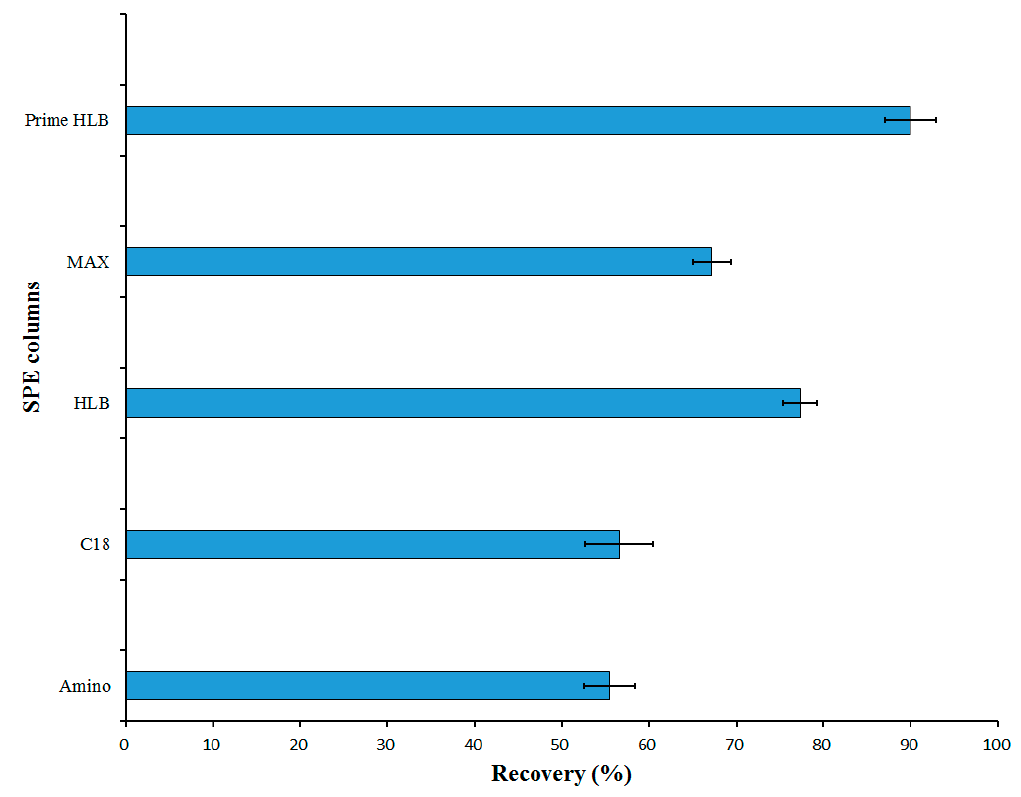
Figure 3. Recovery of different solid phase extraction columns.